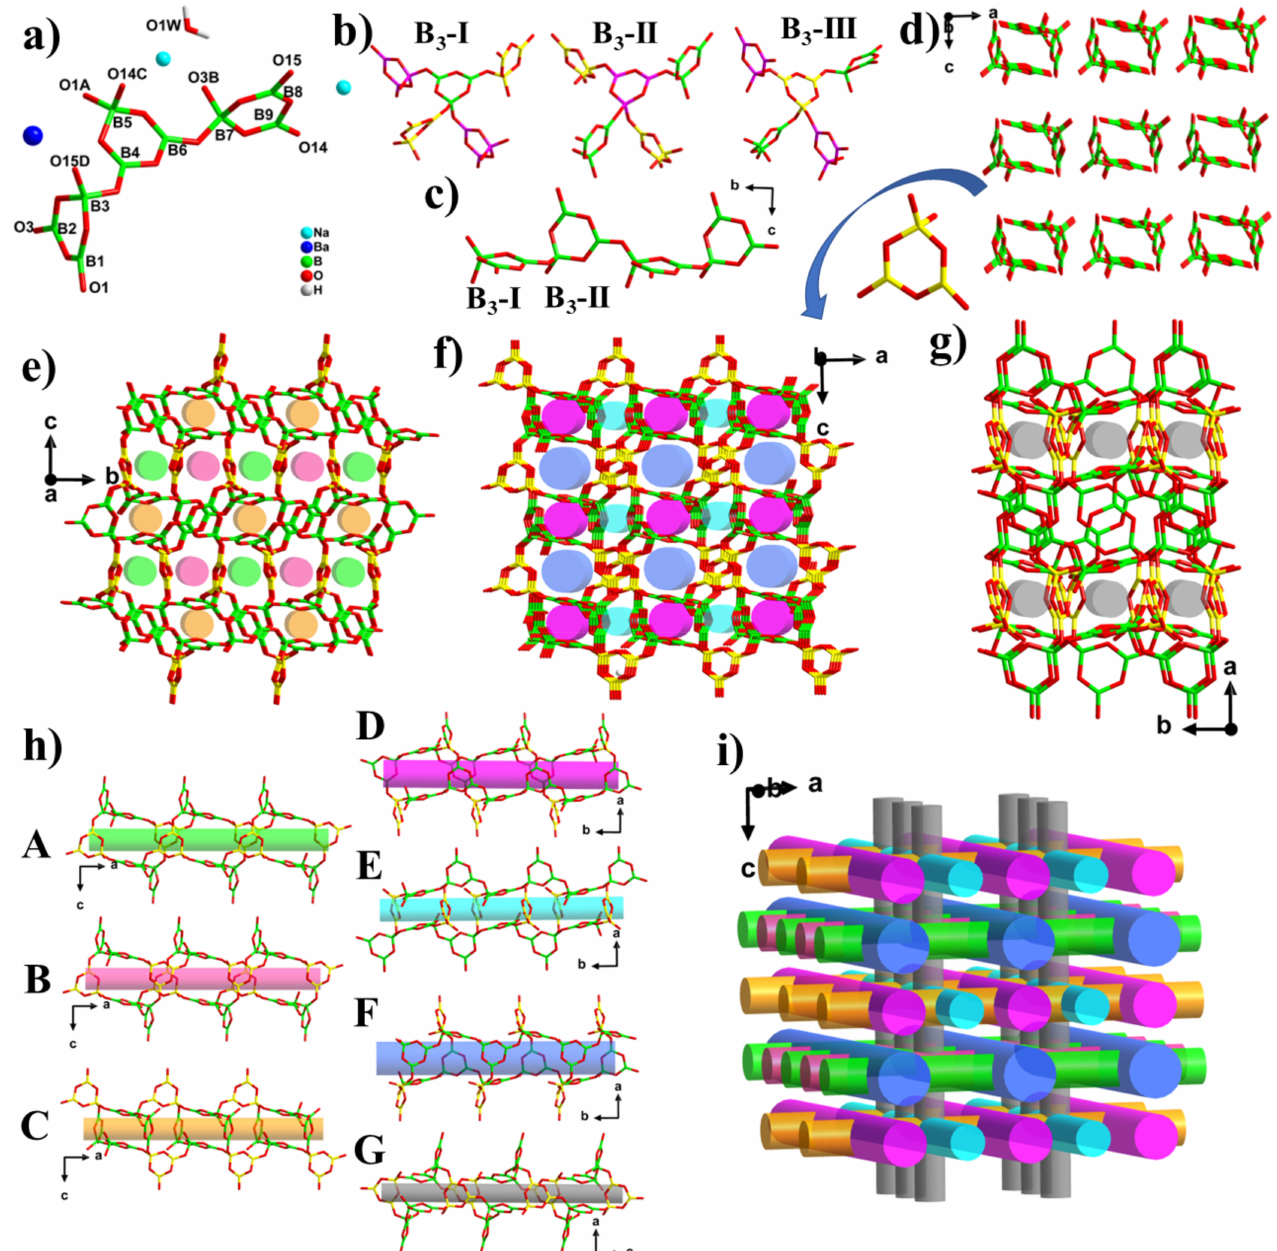
Figure 1. ( a ) Asymmetric unit of 1 . ( b ) Coordination environment of three different B 3 clusters in 1 . ( c ) 1D chain built from the alternation of B 3 -I and B 3 -II. ( d ) The spatial arrangements of the 1D chains in 1 . ( e – g ) View of the 3D framework with seven types of channels from three different directions. ( h ) Side view of the seven types of the 10-MR channels. ( i ) The 3D intercommunicated channel network in 1 . Symmetric codes: A: x, 0.5 − y, − 0.5 + z; B: 1 − x, 1 − y, 1 − z; C: x, − 1 + y, z; D: − x, 1 − y, 1 −